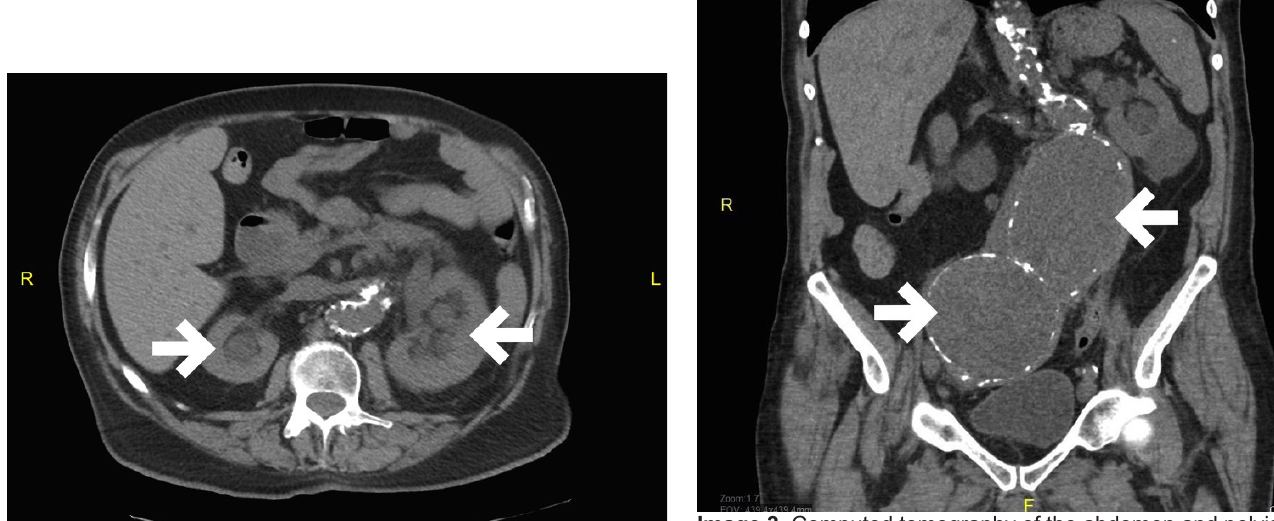
Image 3 . Computed tomography of the abdomen and pelvis